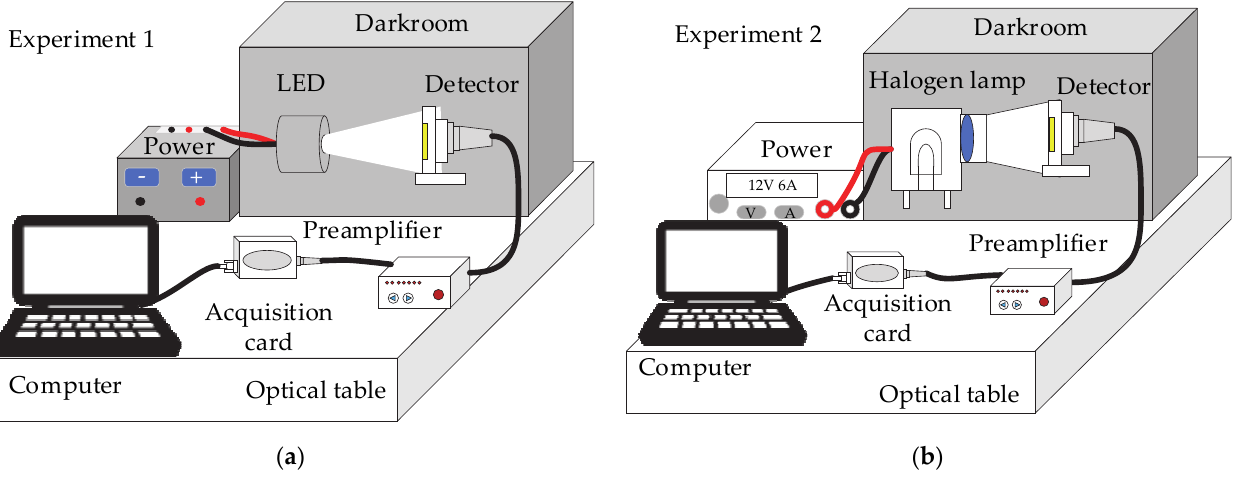
Figure 3. Schematic diagram of the light source stability measurement: ( a ) Device for calibrating PD stability; ( b ) Device for measuring the stability of the light source.